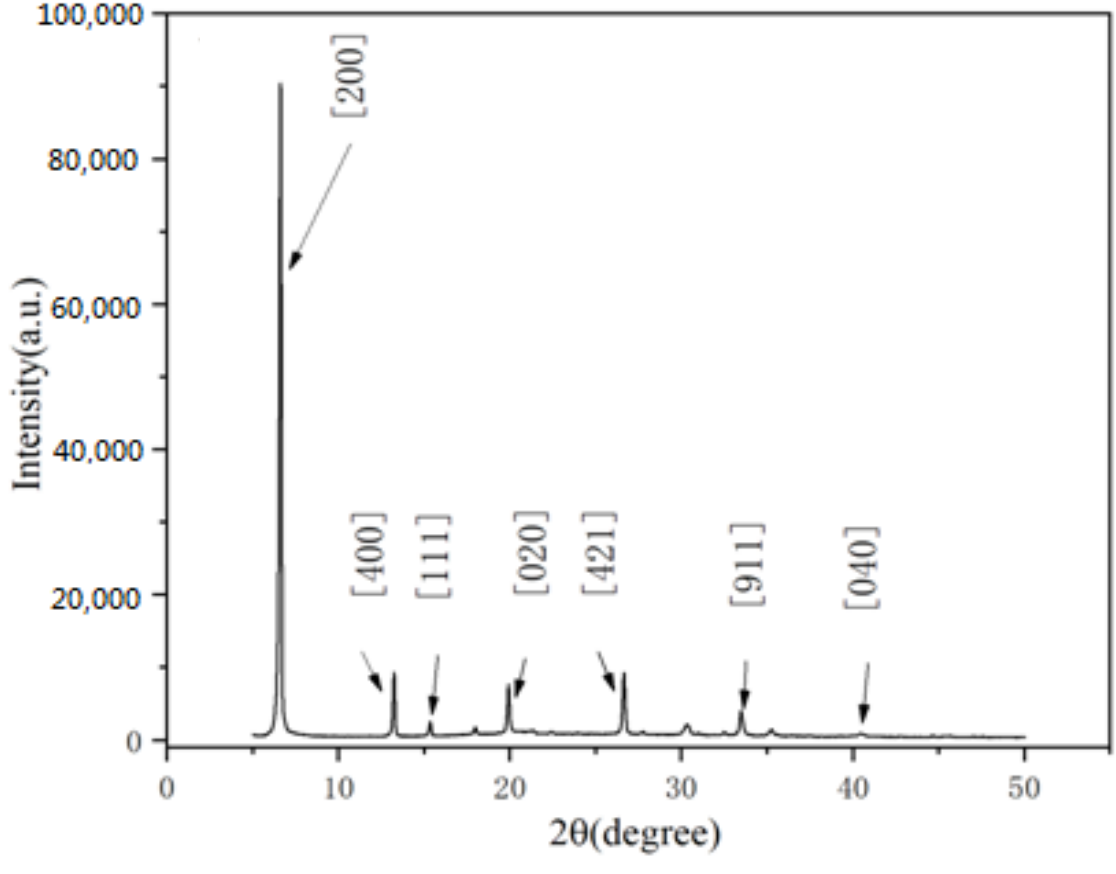
Figure 3. XRD pattern of 0-3 piezoelectric film at an annealing temperature of 90 °C at a speed of 500–1000 rpm.